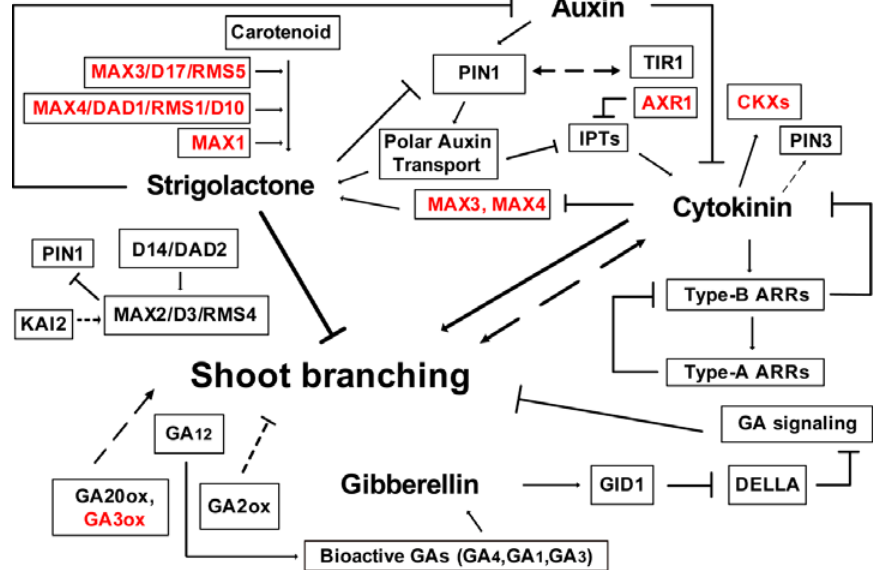
Figure 5. Model of the interaction between auxin, CKs, SLs, and GAs in the control of shoot branching. Dashed arrows and T ‐ bars indicate unknown mechanism. Red genes were not differentially expressed in willow. Arrows and T ‐ bars indicate positive and inhibitory effects, respectively.